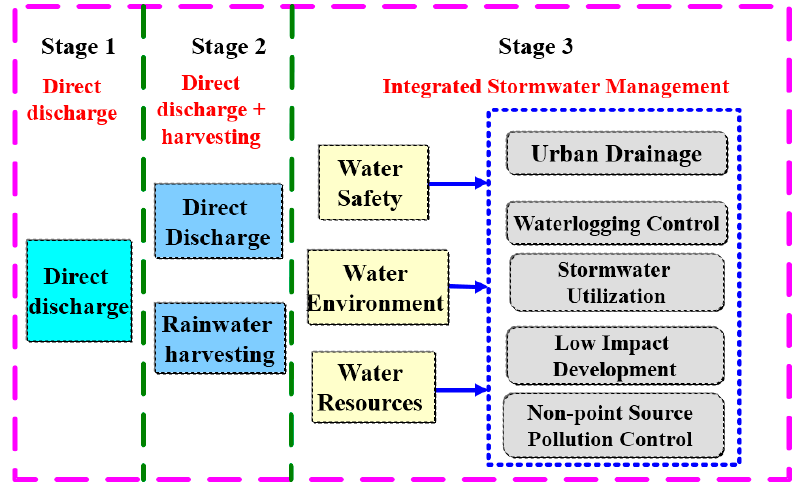
Figure 2. Diagram of Beijing urban rainwater management development.